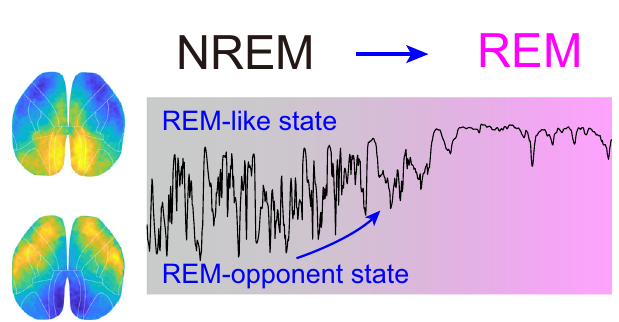
Fig. 8 | Diagram illustrating cortical activity during NREM-to-REM transition. The cortical activity pattern during REM sleep is dominated by elevated activation in the occipital cortex and low activity in the somatic sensorimotor cortex (the REM-like pattern), and such dominance gradually emerges during the NREM-to- REM transition. The cortical activity during NREM sleep oscillates between the REM-like pattern and a REM-opponent pattern. The occurrence of the REM-like pattern is associated with the propensity of brain state transition from NREM to REM sleep. Inhibiting the REM-like pattern by suppressing neuronal activity in the occipital cortex can retain the brain state in the REM-opponent state, thus pre- venting the transition from NREM to REM